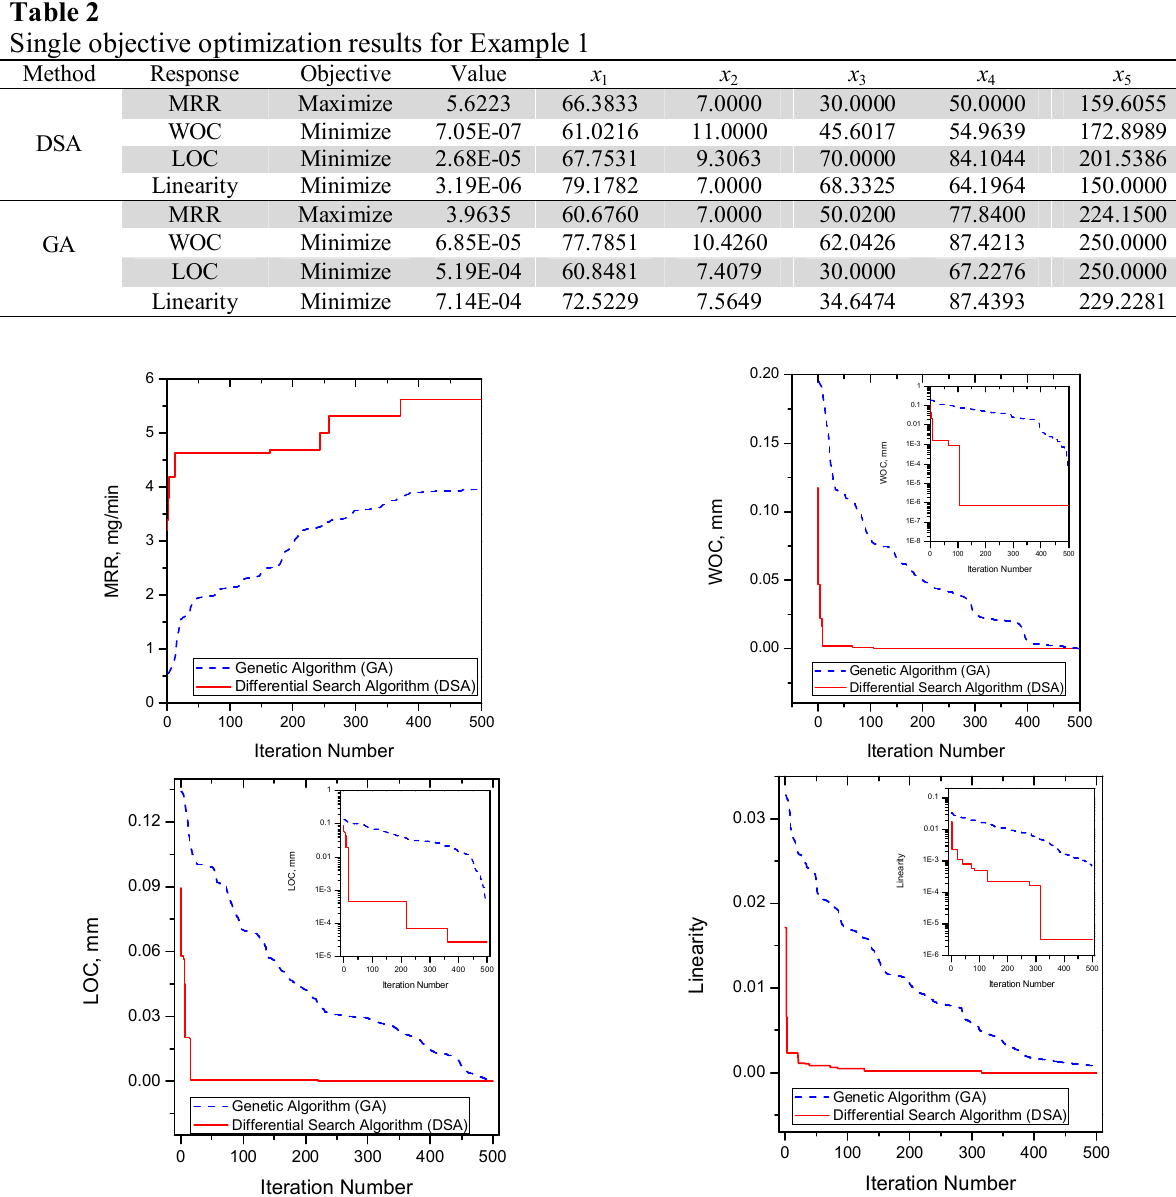
Genetic Algorithm (GA) Differential Search Algorithm (DSA)